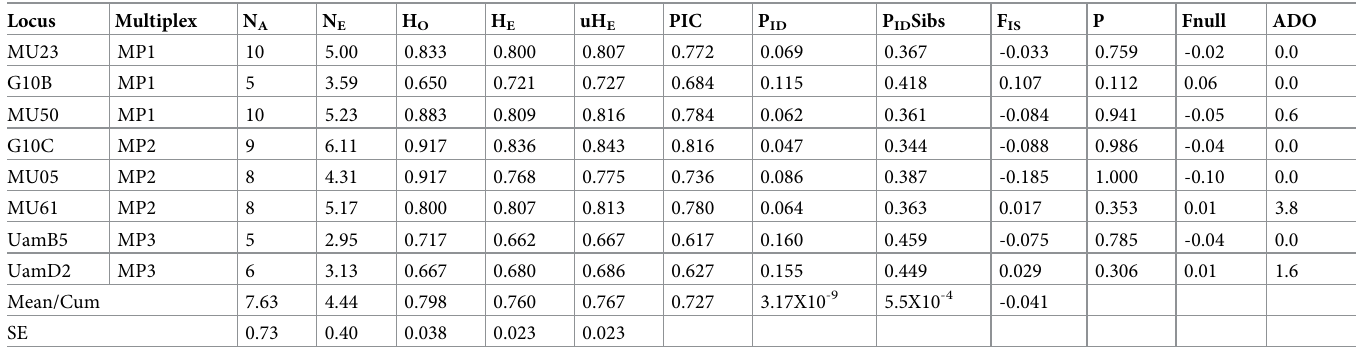
Table 2. Genetic variability parameters for the 8 microsatellite loci used to evaluate the population of Annapurna Conservation Area, Nepal (N = 60 individuals).